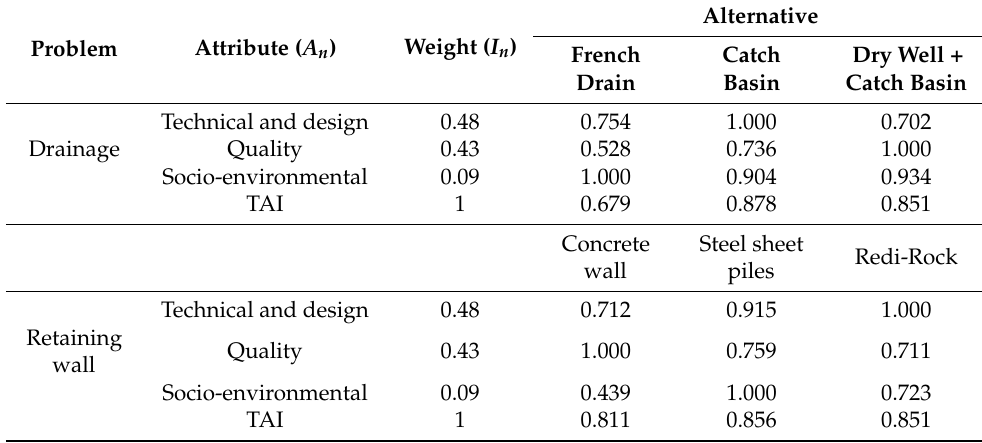
Table 13. The benefits associated with the evaluated alternatives.